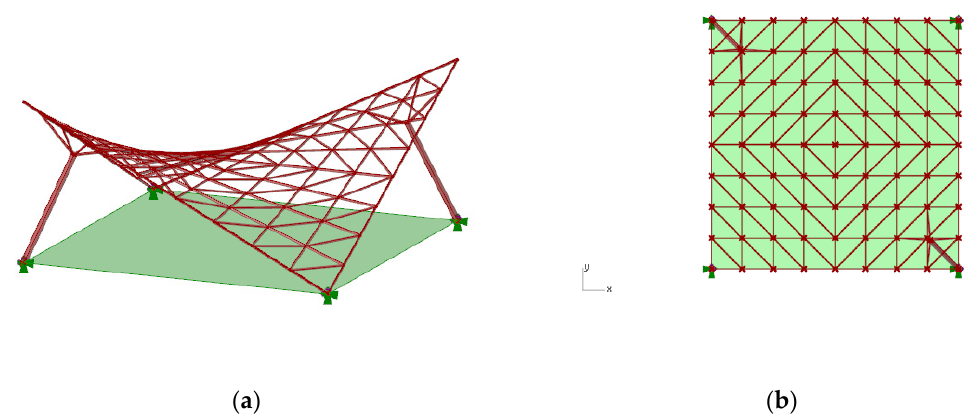
Figure 3. Grasshopper scrips for the definition of: ( a ) the hyperbolic paraboloid and ( b ) the cylindroid.